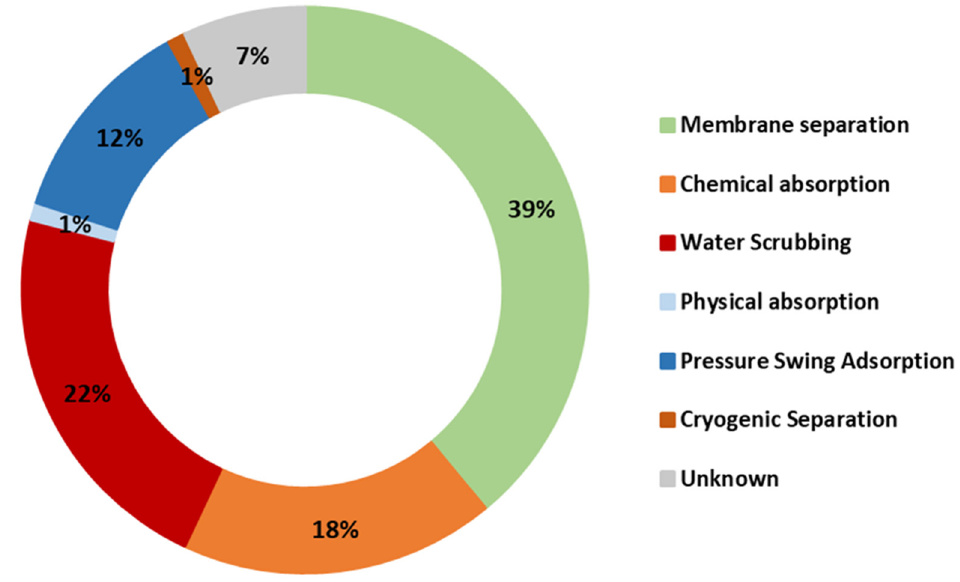
Figure 1. Market share of different upgrading technologies in Europe in 2020. Figure adapted from EBA, 2021.